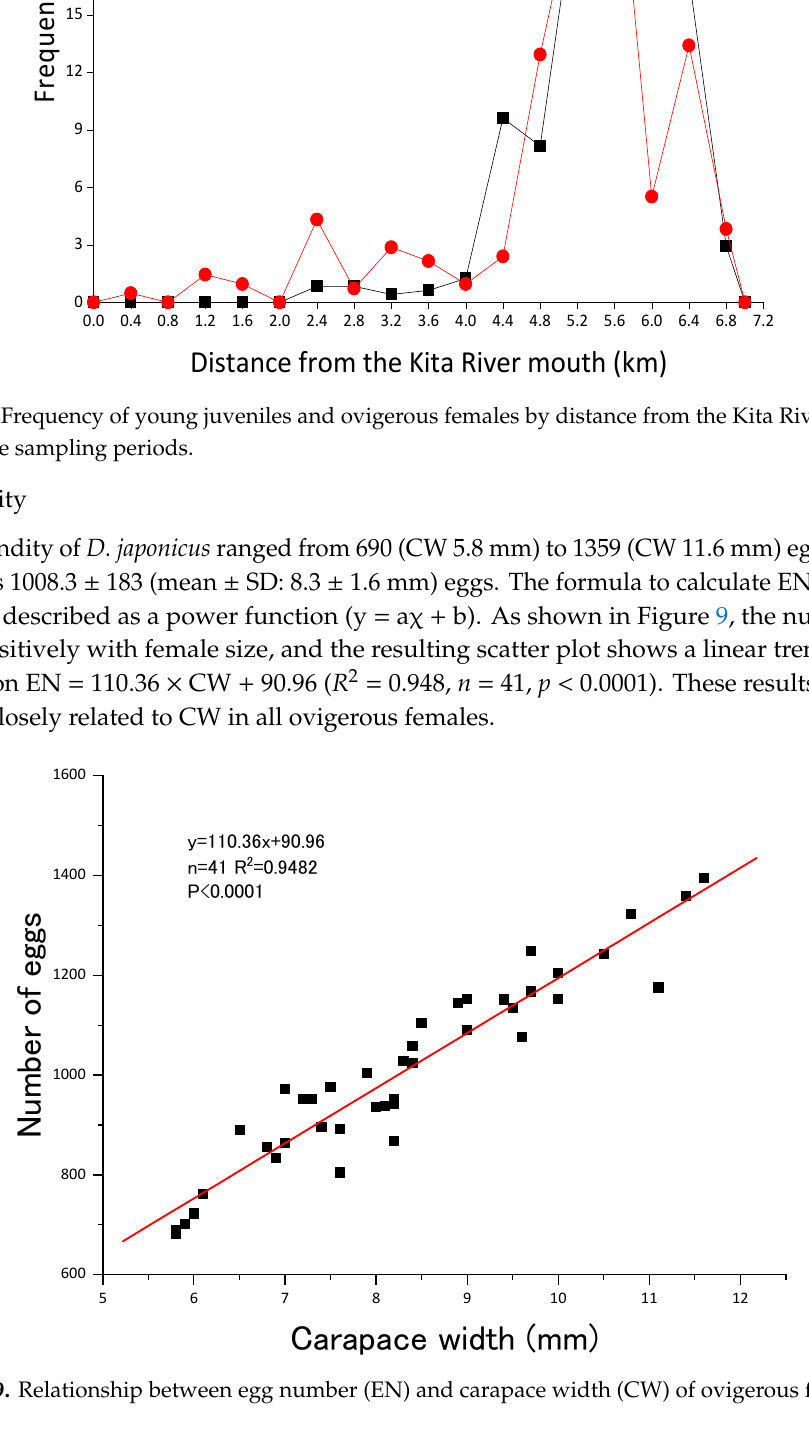
Figure 9. Relationship between egg number (EN) and carapace width (CW) of ovigerous